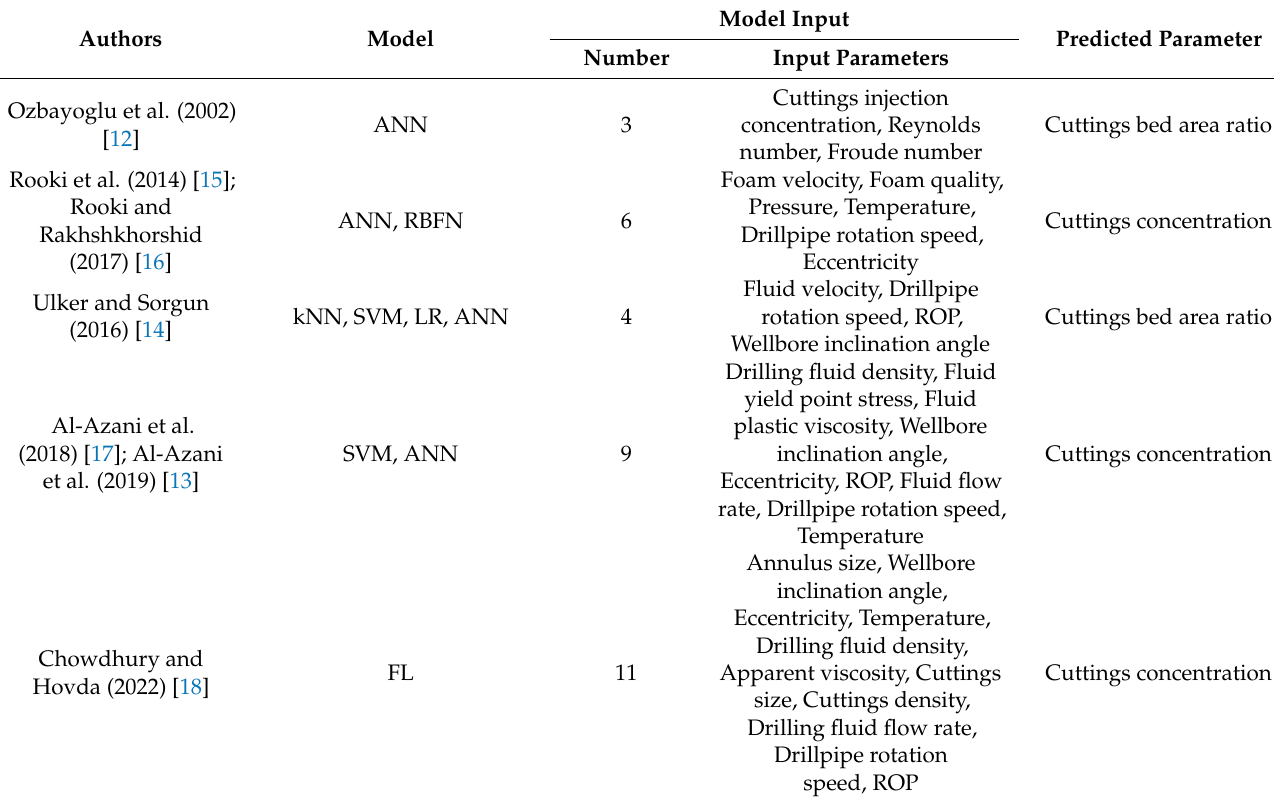
Table 1. Summarization of intelligent models for the prediction of cuttings transport